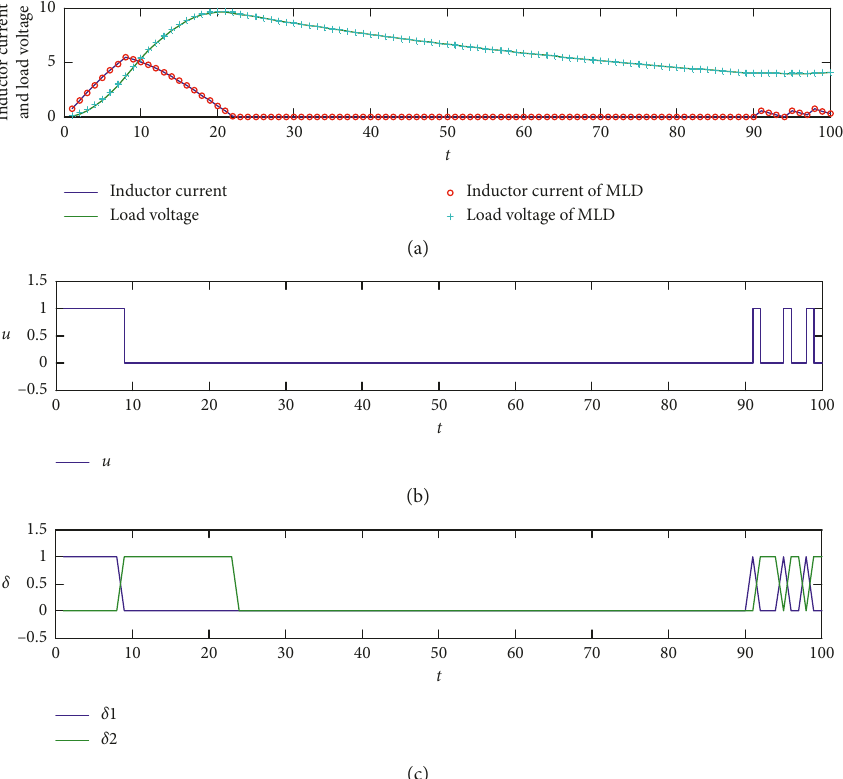
Figure 4: Curve of inductor current, output voltage, system input, and model state of MSMLD. (a) System state and model state. (b) Control input. (c) Auxiliary logic variable.